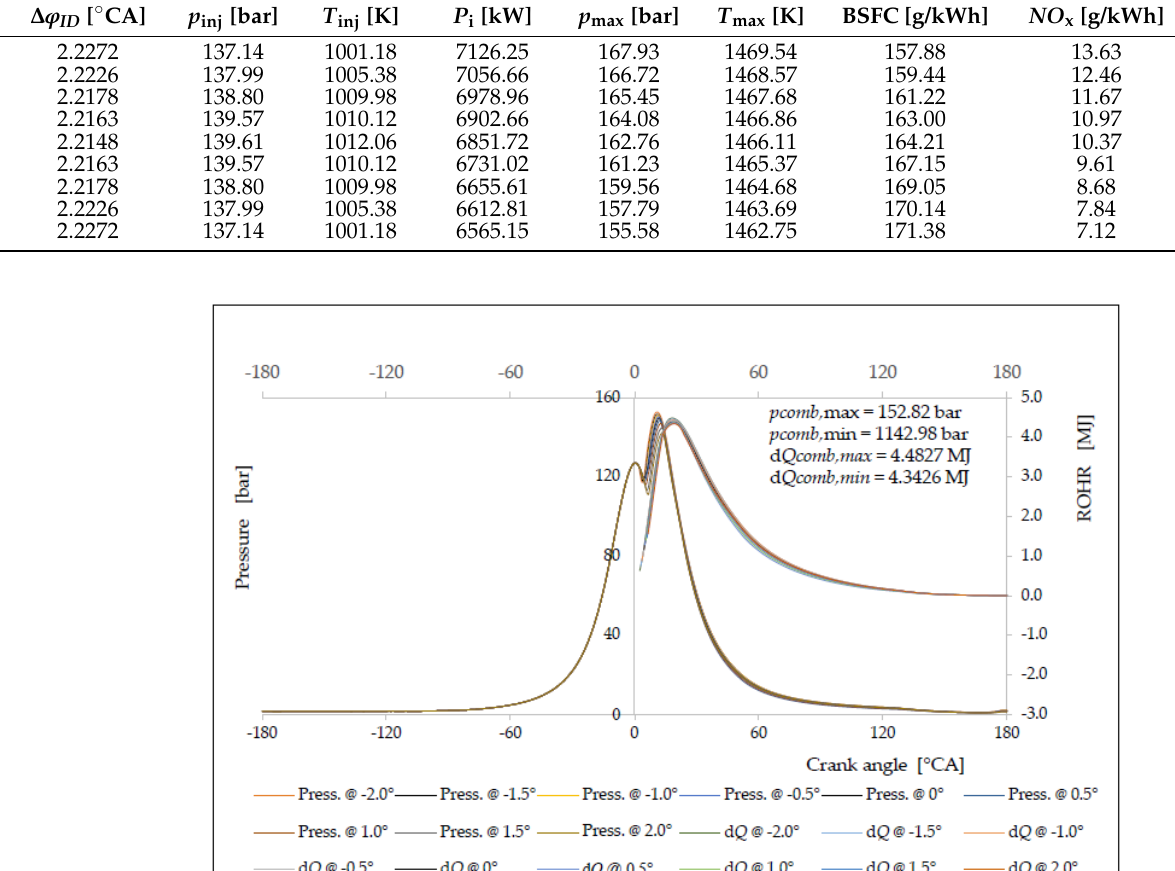
Table 10. Parameters and NO x emission changes due to changes in fuel injection timing at 75% MCR [22].